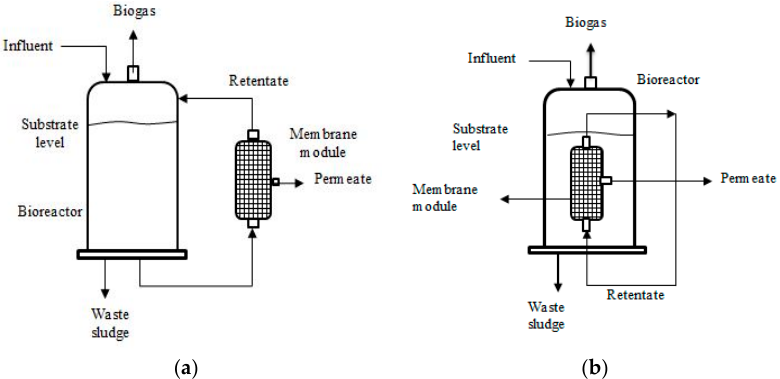
Figure 1. A schematic of AnMBR configurations—( a ) Side or external membrane ( b ) submerged membrane. Membrane Configuration